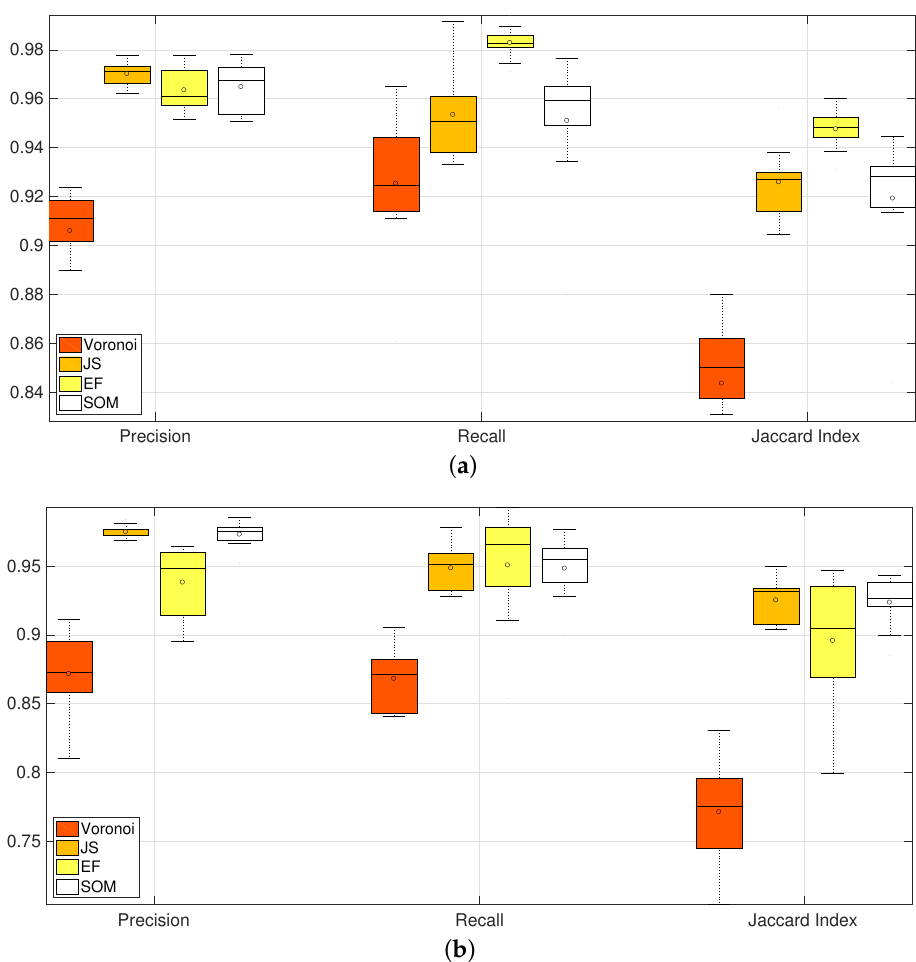
Figure 15. Comparison of Precision, Recall and Jaccard Index for all methods of segmentation of overlapping in clumps 2 and 3. Horizontal axis correspond to the box plots from the different methods and their summarised performance in the metrics computed. Three groups corresponding to Precision, Recall and Jaccard Index contain four box plots; which, from left to right, correspond to Voronoi, JS, EF and SOM methods. Table 1 summarises the information on this image. [17] Reproduced with permission. ( a ) CLUMP 2. Y-axis ranges from ( 0.82,1 ) ; ( b ) CLUMP 3. Y-axis ranges from ( 0.7,1 )